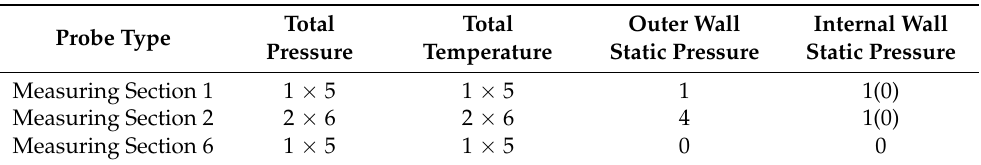
Figure 4. General schematic of the 11D turbofan aero engine. Table 2. Measuring content and distribution of measuring points (number of probes × number of span-wise measuring